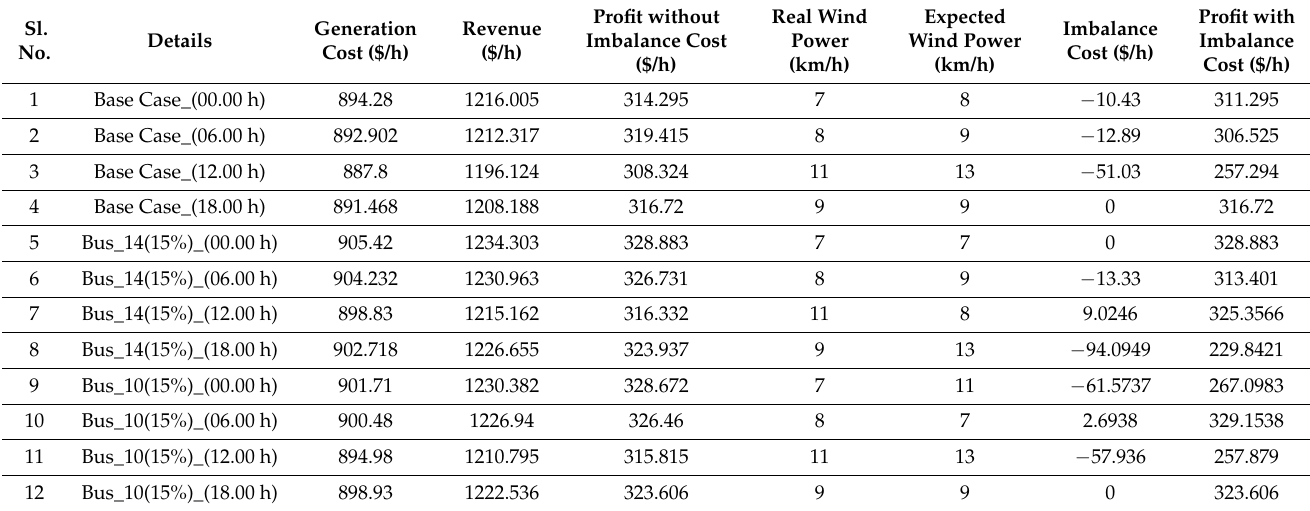
Table 6. Profit Comparison with Considering Imbalance Cost